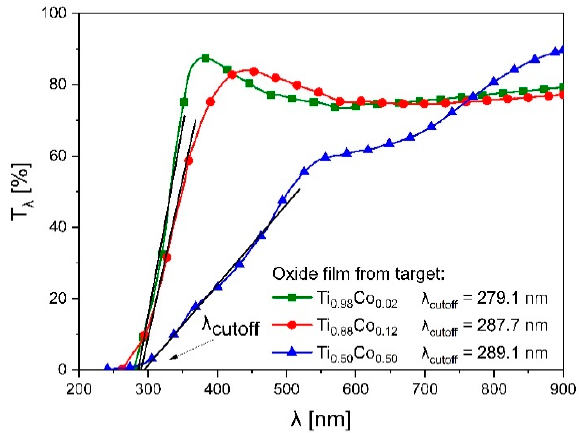
Figure 10. Transmission characteristics of (Ti,Co)Ox thin films prepared from different targets. Designations: T λ —light transmission coefficient, λ cutoff —position of the optical absorption edge.